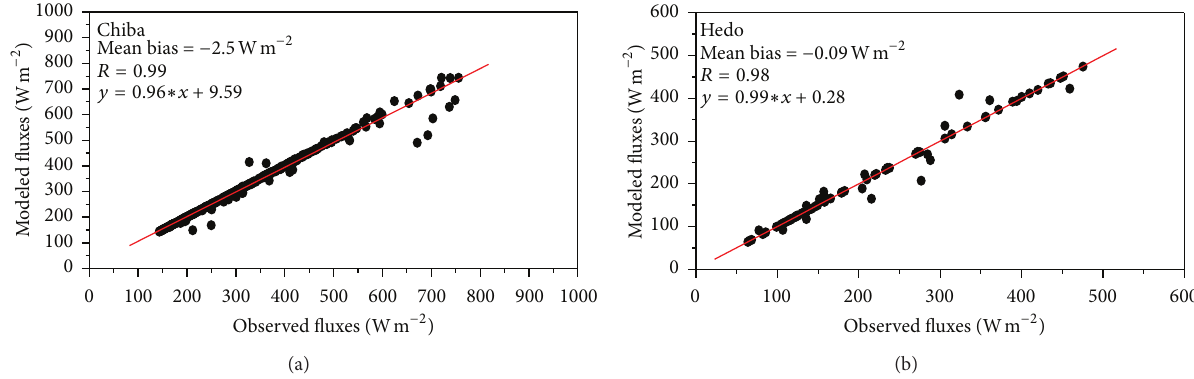
Figure 4: Comparison of observed and model simulated fluxes using the best combinations of 𝜏 𝑐 and 𝑅 (b) Hedo (diffuse